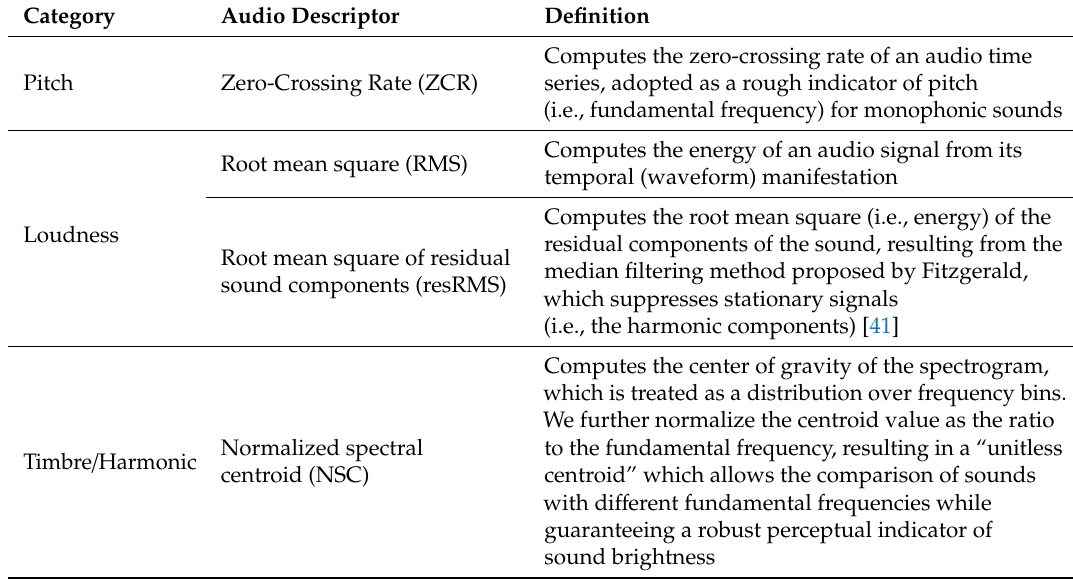
Table 1. List of score-independent audio descriptors adopted in our study as objective metrics for trumpet sound